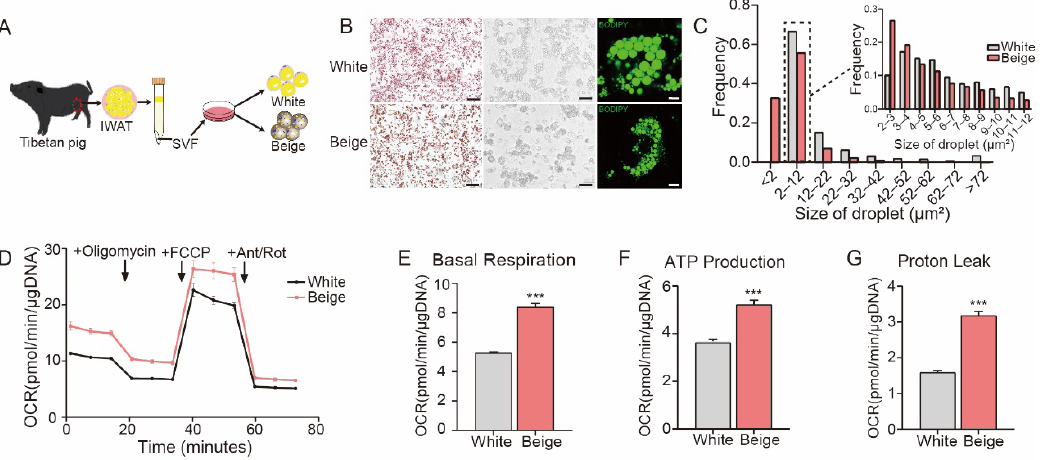
Figure 1. The Establishment of an in vitro model of porcine beige adipogenesis. ( A ) Schematic illustration of the in vitro differentiation of porcine beige and white adipocytes. ( B ) Oil Red-O staining (left panel), bright field imaging (middle panel), BODIPY 493/503 fluorescence staining (right panel) of white and beige adipocytes (scale bars are 200 μm, 50 μm and 10 μm, respectively). ( C ) Frequency statistical data of lipid droplet size measurements in white and beige adipocytes based on the bright field images shown in ( B ) (white: n = 5943; beige: n = 5974, pixel: 1 μm). ( D ) The oxygen consumption rates (OCRs) of white and beige adipocytes were measured by the Seahorse Mito Stress Test assay. Oligomycin (1.5 μM), FCCP (0.5 μM) and antimycin A/rotenone (0.5 μM) were added at the indicated time points. The data were normalized to the total DNA content. ( E – G ). The basal respiration rate ( E ), ATP production ( F ) and proton leak ( G ) were calculated based on the data presented in D ( n = 10). All data are shown as the mean ± SEM. The p value was calculated by unpaired two-tailed Student’s t test. *** p < 0.001.